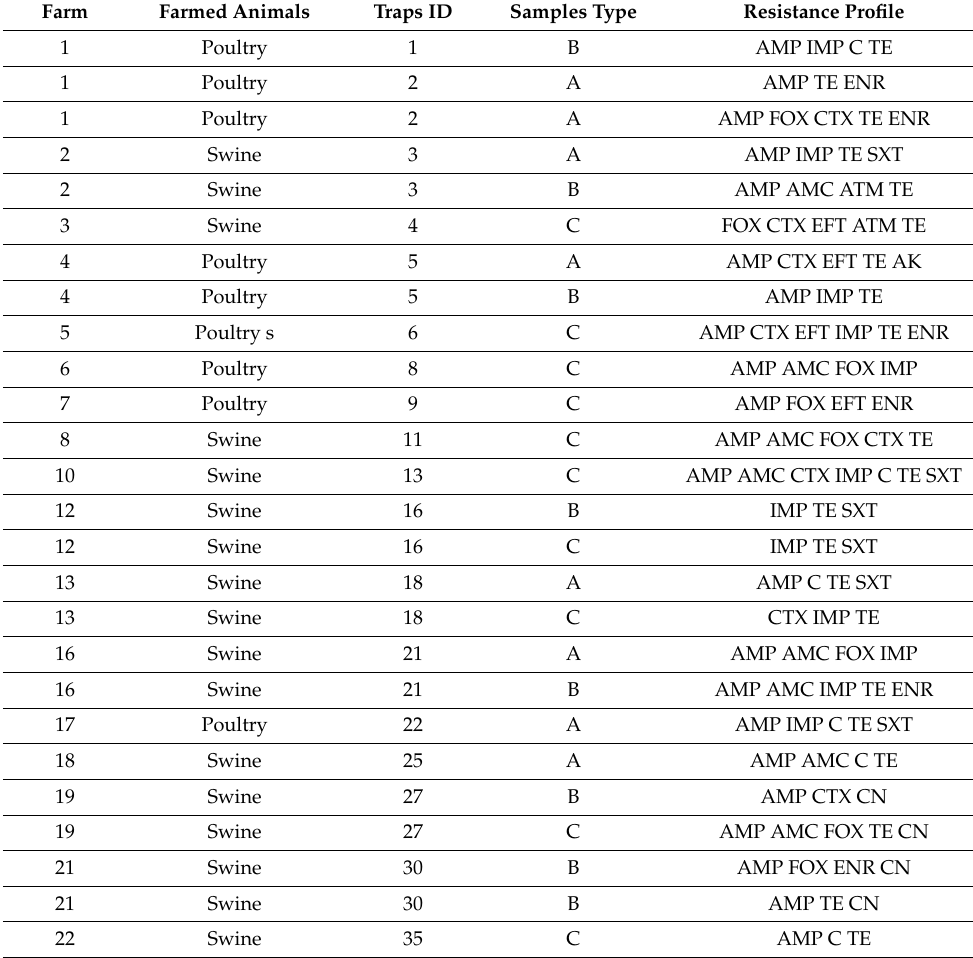
Table 3. Multi-drug resistant Enterobacteriaceae